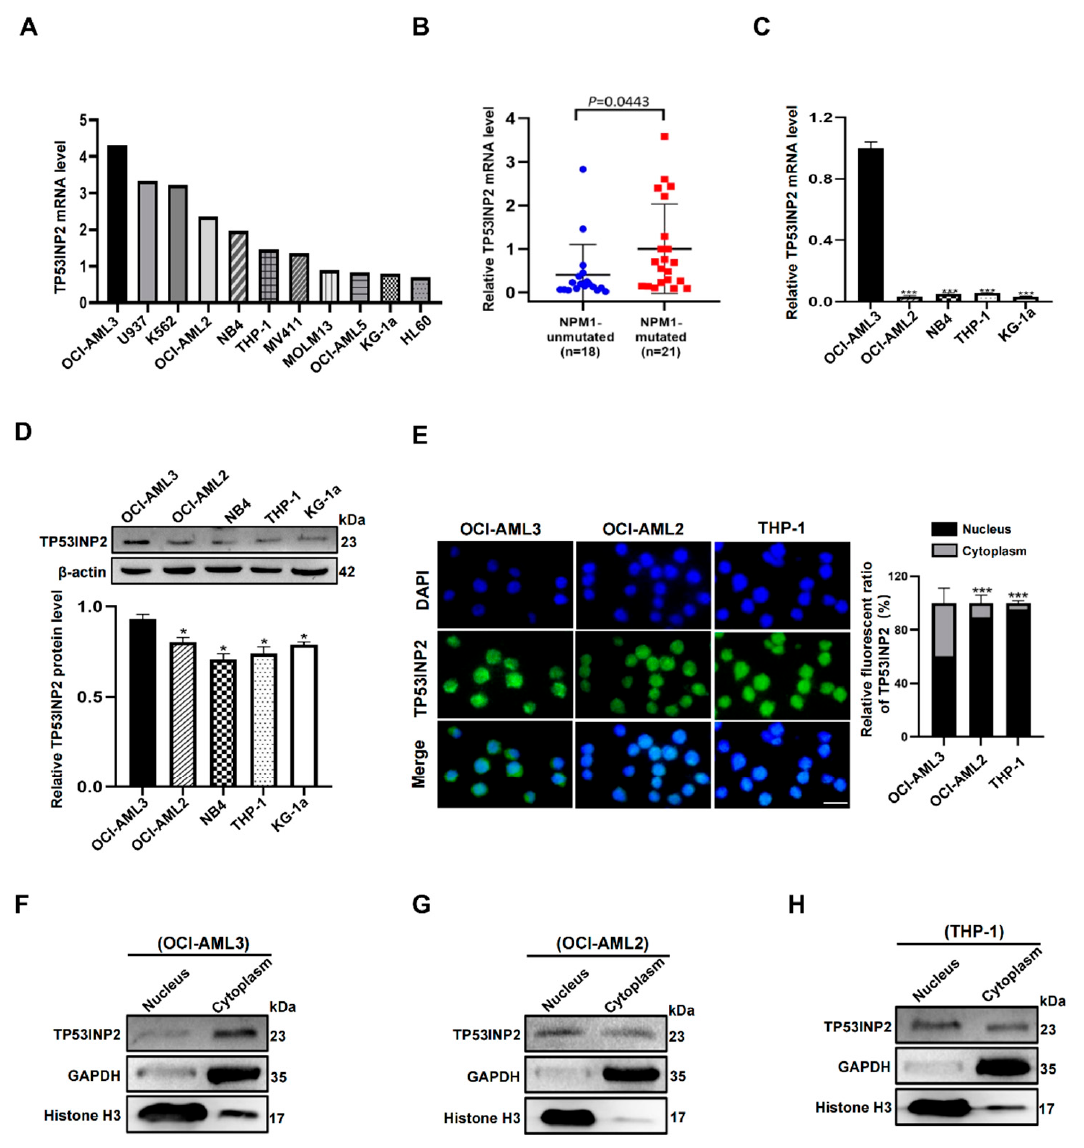
Figure 2. High expression and cytoplasmic localization of TP53INP2 in NPM1 -mutated leukemia cells. ( A ) The expression of TP53INP2 in leukemia-lymphoma cell lines from the CCLE database. ( B , C ) qRT-PCR analysis of relative TP53INP2 mRNA expression in primary AML blasts and human AML cell lines. ( D ) Western blot analysis of TP53INP2 protein levels in human AML cell lines. β -actin was used as the control. The bar graph showed relative protein levels. ( E ) immunofluorescence analysis ( × 400) of TP53INP2 localization in OCI-AML3 cells versus OCI-AML2 and THP-1 cells. Cytoplasmic versus nuclear TP53INP2 in OCI-AML3, OCI-AML2, and THP-1 cells were quantified